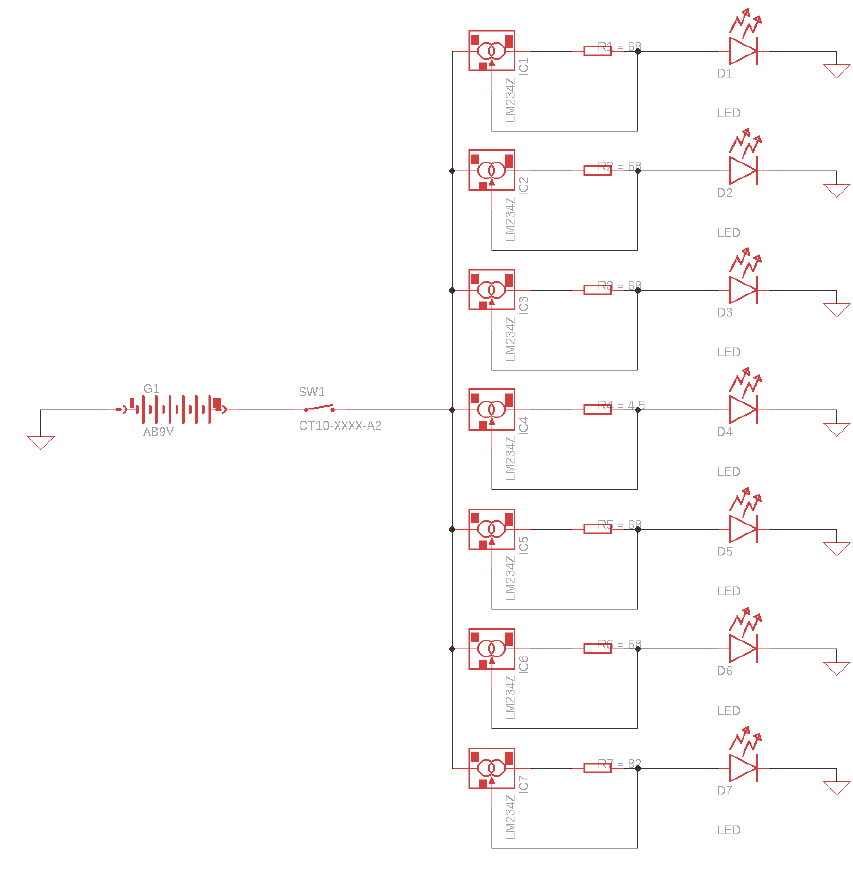
Table 3. Constant current conditions for each UV LED in the calibrator circuit.